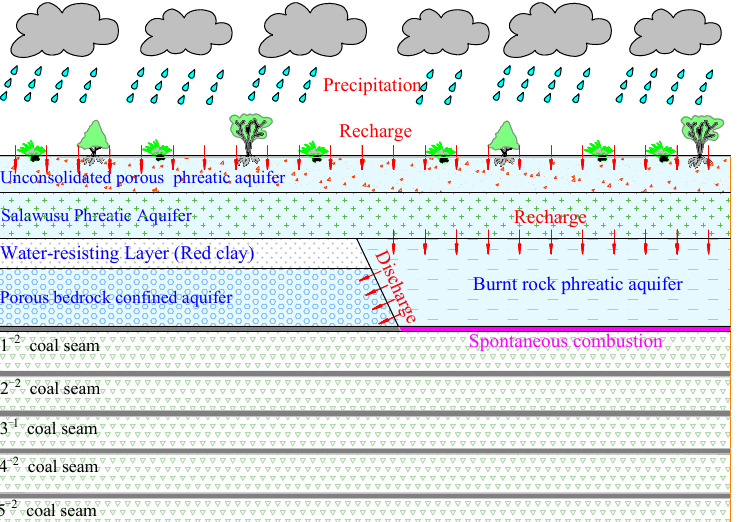
Figure 14. The major types of aquifers in Yu-Shen mining area.